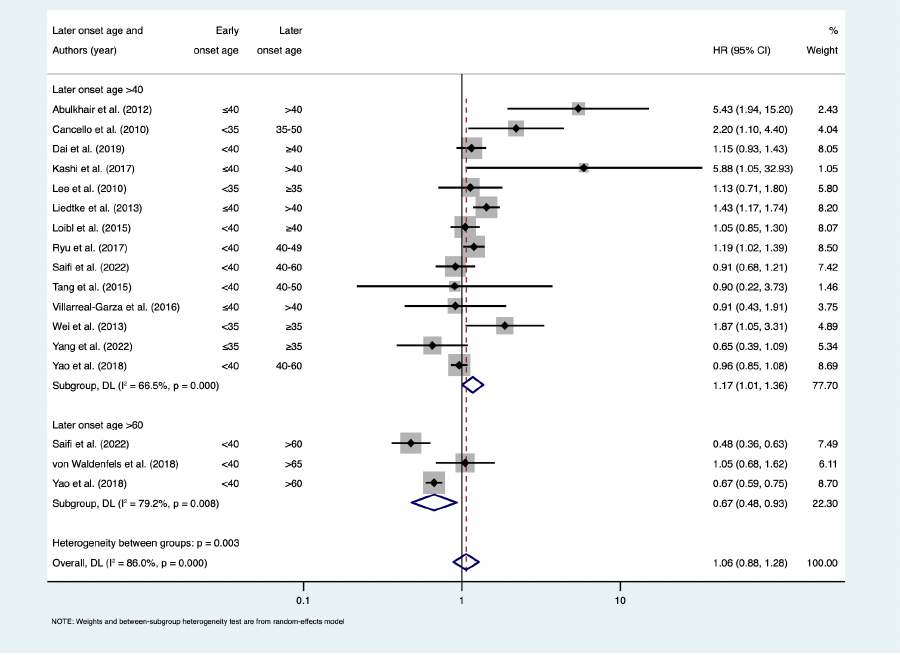
Figure 6. Forest plot for meta-analysis of pathological complete response (pCR). Odds ratios less than 1 show lower odds of achieving pCR in early-onset age group; Odds ratios greater than 1 show higher odds of achieving pCR in early-onset age group. References [24,26,37,43–45]. Abbreviations: CI = confidence interval; OR = odds ratio.